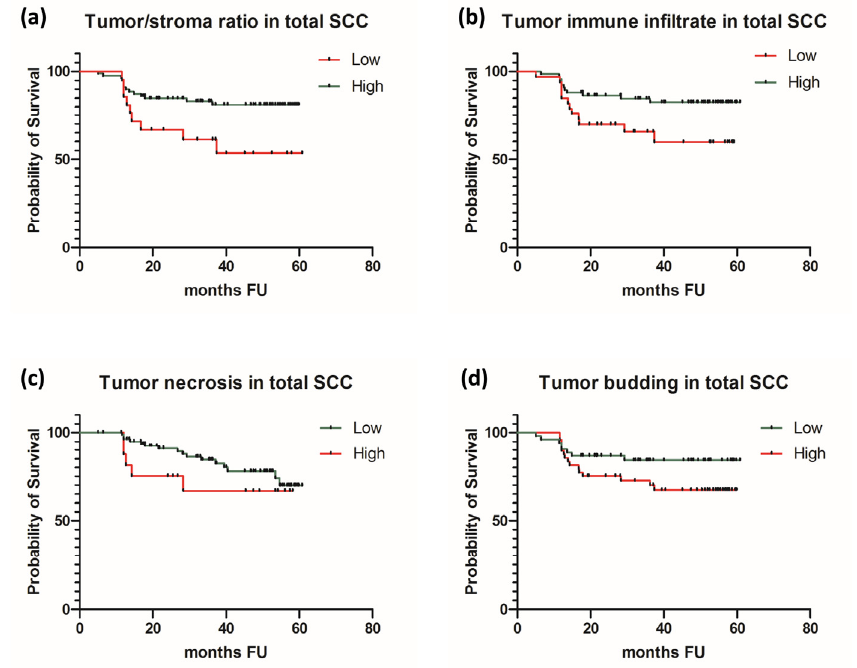
Figure 3. Survival curves in total SCC for ( a ) tumor/stroma ratio, ( b ) immune infiltration at the front of invasion, ( c ) tumor necrosis, and ( d ) tumor budding.